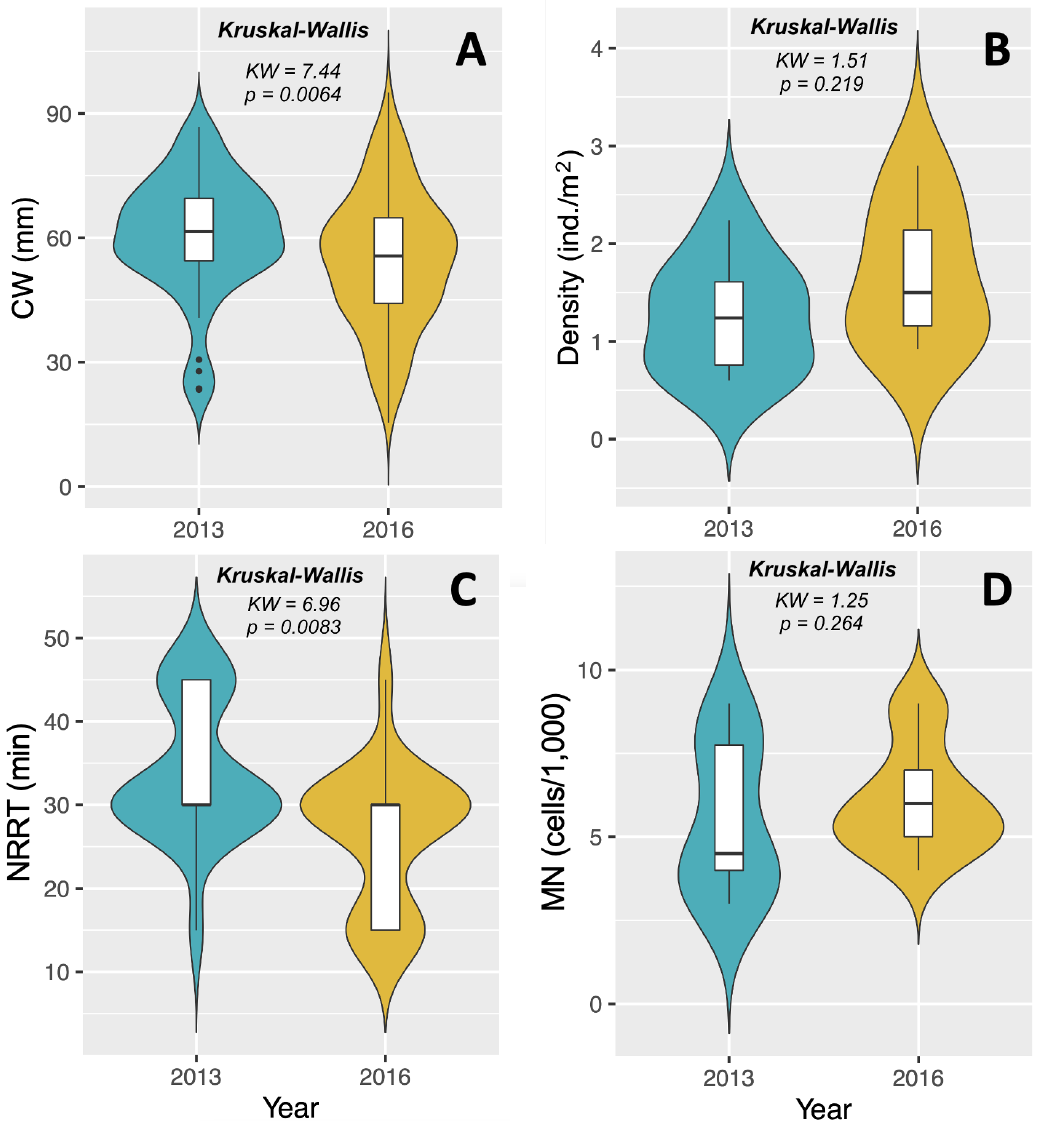
Figure 2. Population parameters and cytogenetic markers registered in the mangrove crab ( Ucides cordatus ), from Cubatão municipality (Brazil), based on two temporal periods bracketing an environmental disaster (2013: pre-disaster; and 2016: post-disaster). (A) crab size (CW, carapace width in millimeters); (B) population density (ind./m 2); (C) cytotoxicity biomarker (NRRT, neutral red retention time, in minutes); and (D) genotoxicity biomarker (MN, micronucleus assay, as micronucleated cells/1,000). Where: violin plot, represents kernel probability density; box plot, represented by median (horizontal line), box (IQR, interquartile range) and whiskers (1.5 times plus